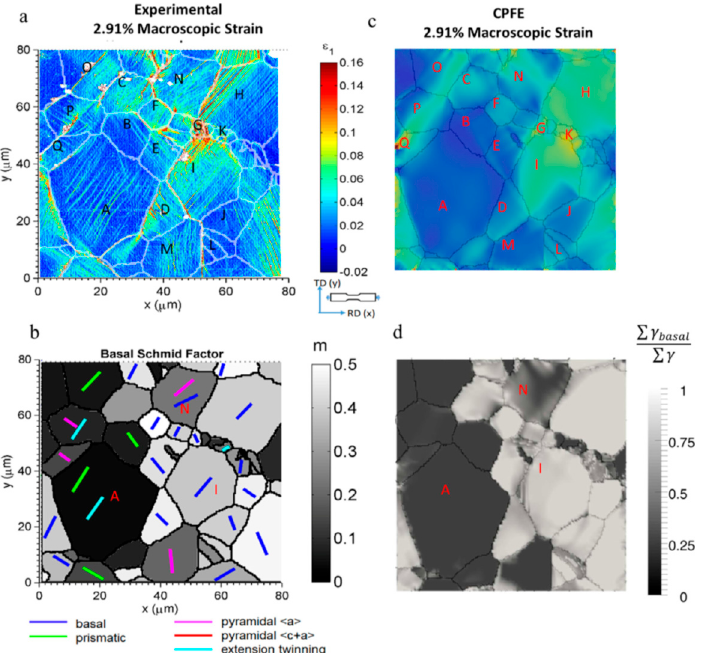
Figure 18. Identification of active deformation mode using SEM-DIC experiment and CPFE simulation at a tensile strain of ε = 2.91% ( a ) SEM-DIC strain map, ( b ) slip traces for different deformation mode along with the basal Schmid factor map, ( c ) CPFE simulation strain map, ( d ) the activity of basal slip system obtained from CPFE simulation (After Githens et al. [25]).